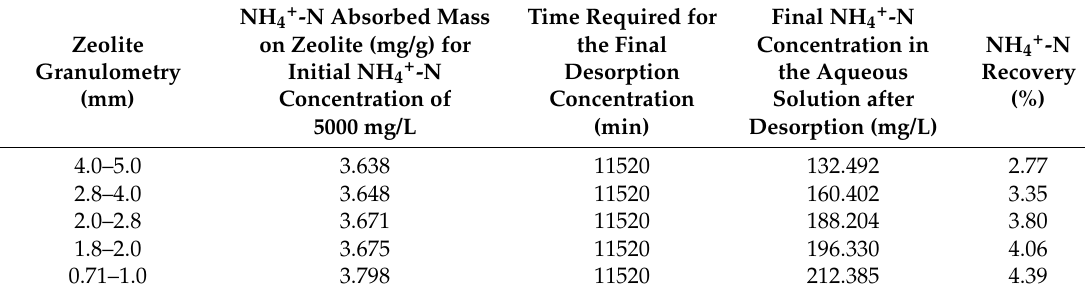
Table 5. Results of the column desorption